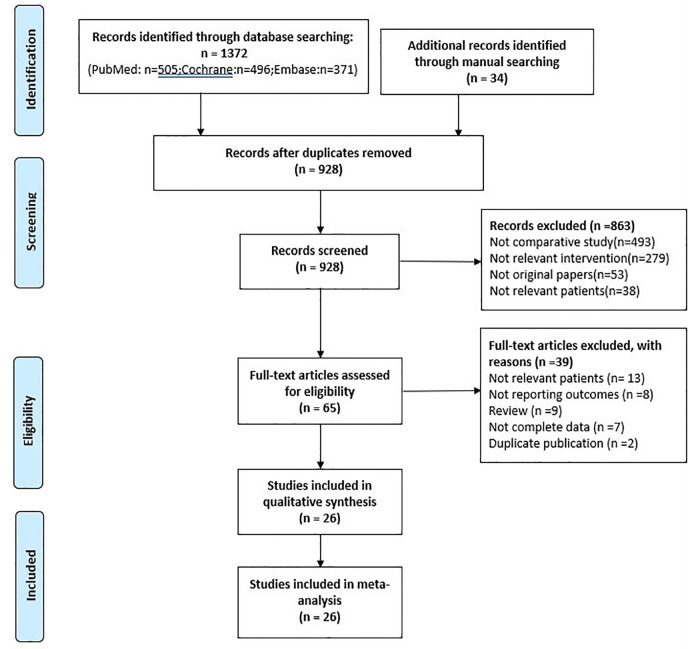
PRISMA flow diagram.